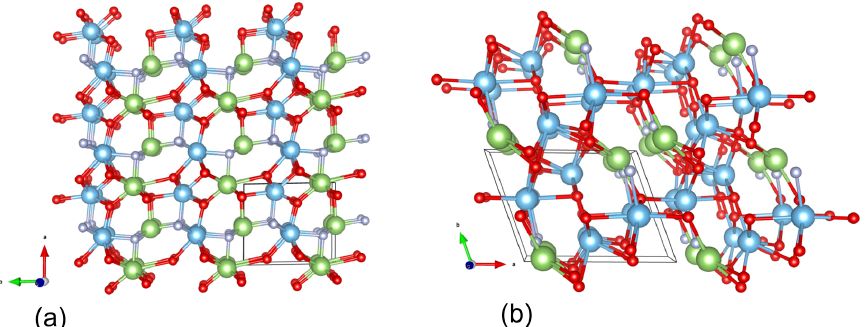
Figure 1. The lowest enthalpy structures of ( a ) GaTiO 2 N and ( b ) GaTi 2 O 4 N predicted at 20 GPa. Green and blue spheres are gallium and titanium atoms, respectively. Oxygen and nitrogen are represented by red and silver spheres, respectively. The unit cells are outlined with black lines. Visualization is done by VESTA [29].